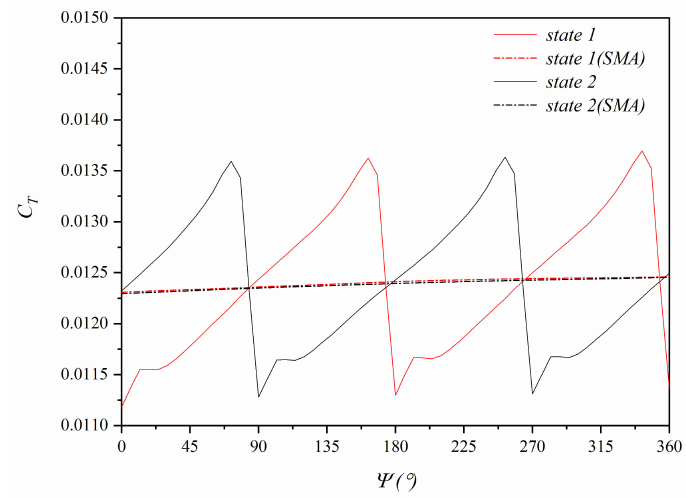
Figure 13. The isolated rotor C T in hover.